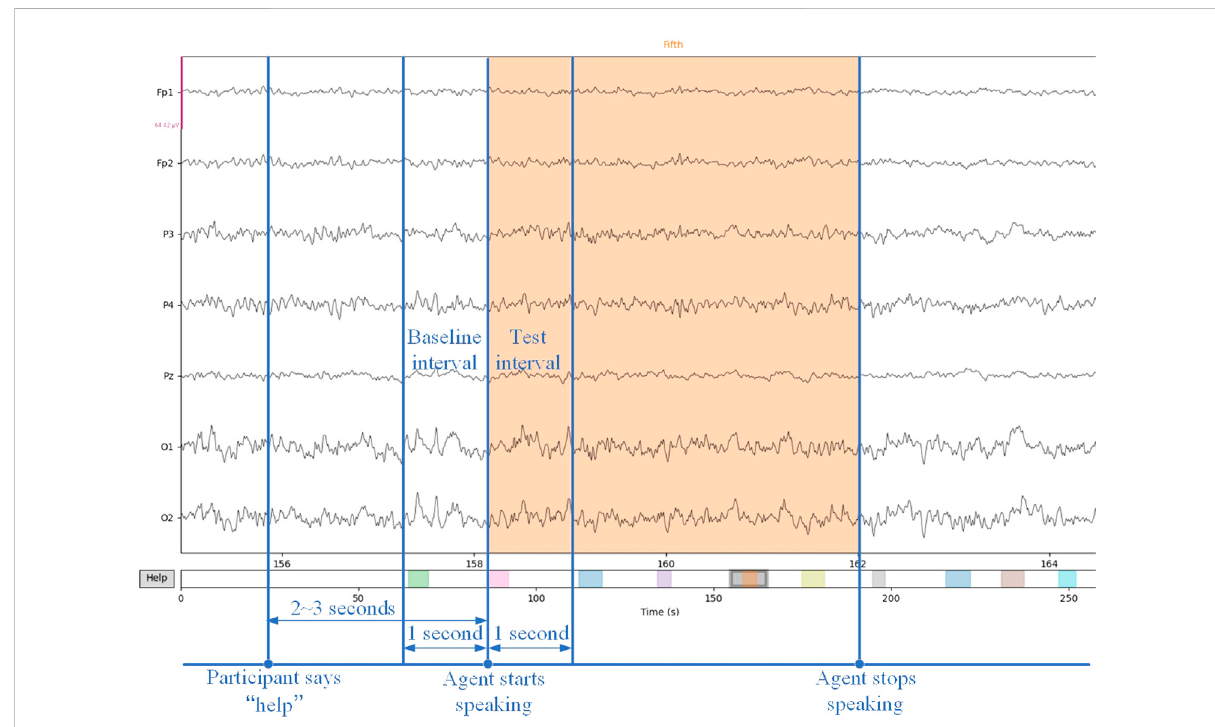
FIGURE 3 This fi gure demonstrates baseline interval and test interval for calculating the ERD/ERS. Each colorful bar represents a time window when the agent was